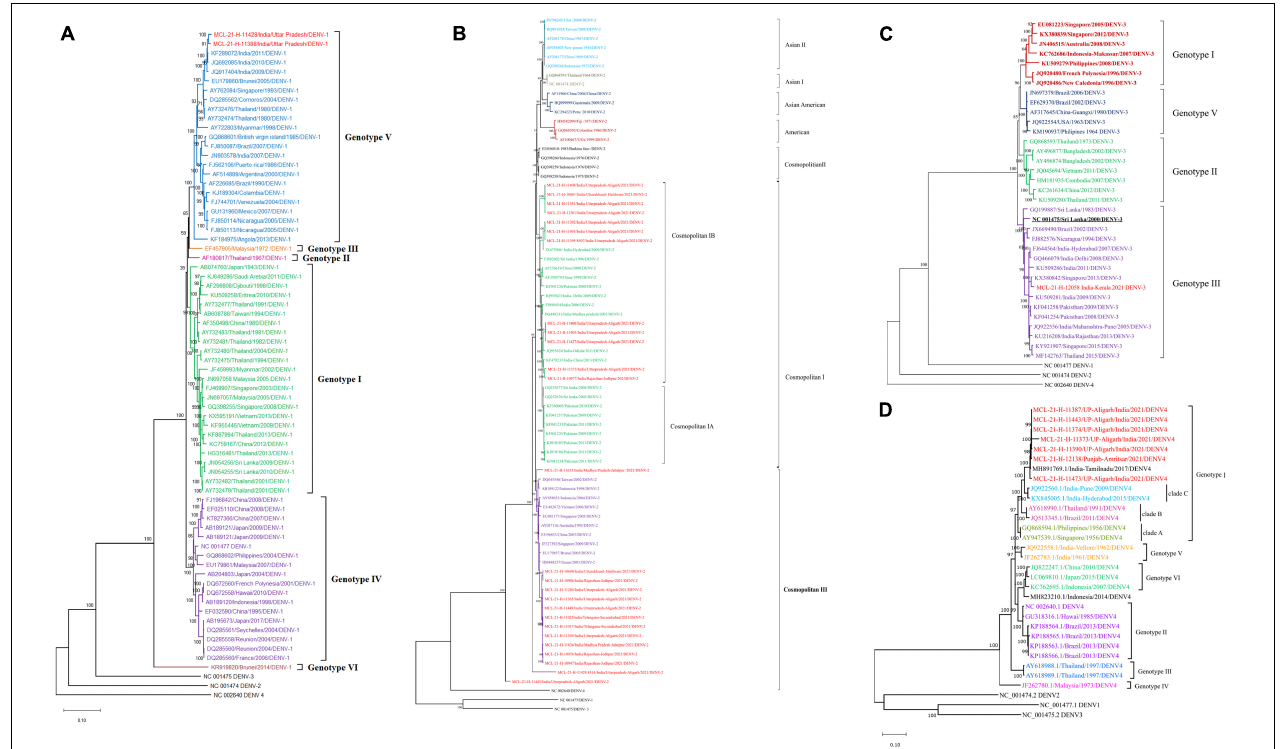
FIGURE 4 | (A–D) The phylogenetic tree constructed with Neighbor Joining (NJ) method for DENV using the Tamura 3 as substitution model and a bootstrap replication of 1000 cycles. (A) DENV-1 serotype; (B) DENV-2 serotype; (C) DENV-3 serotype, and (D) DENV-4